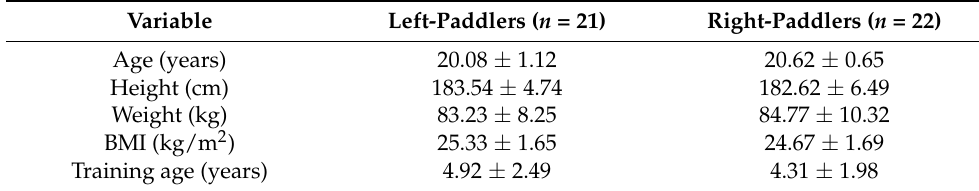
Table 1. Demographic information of participants ( x ± s, n = 43).